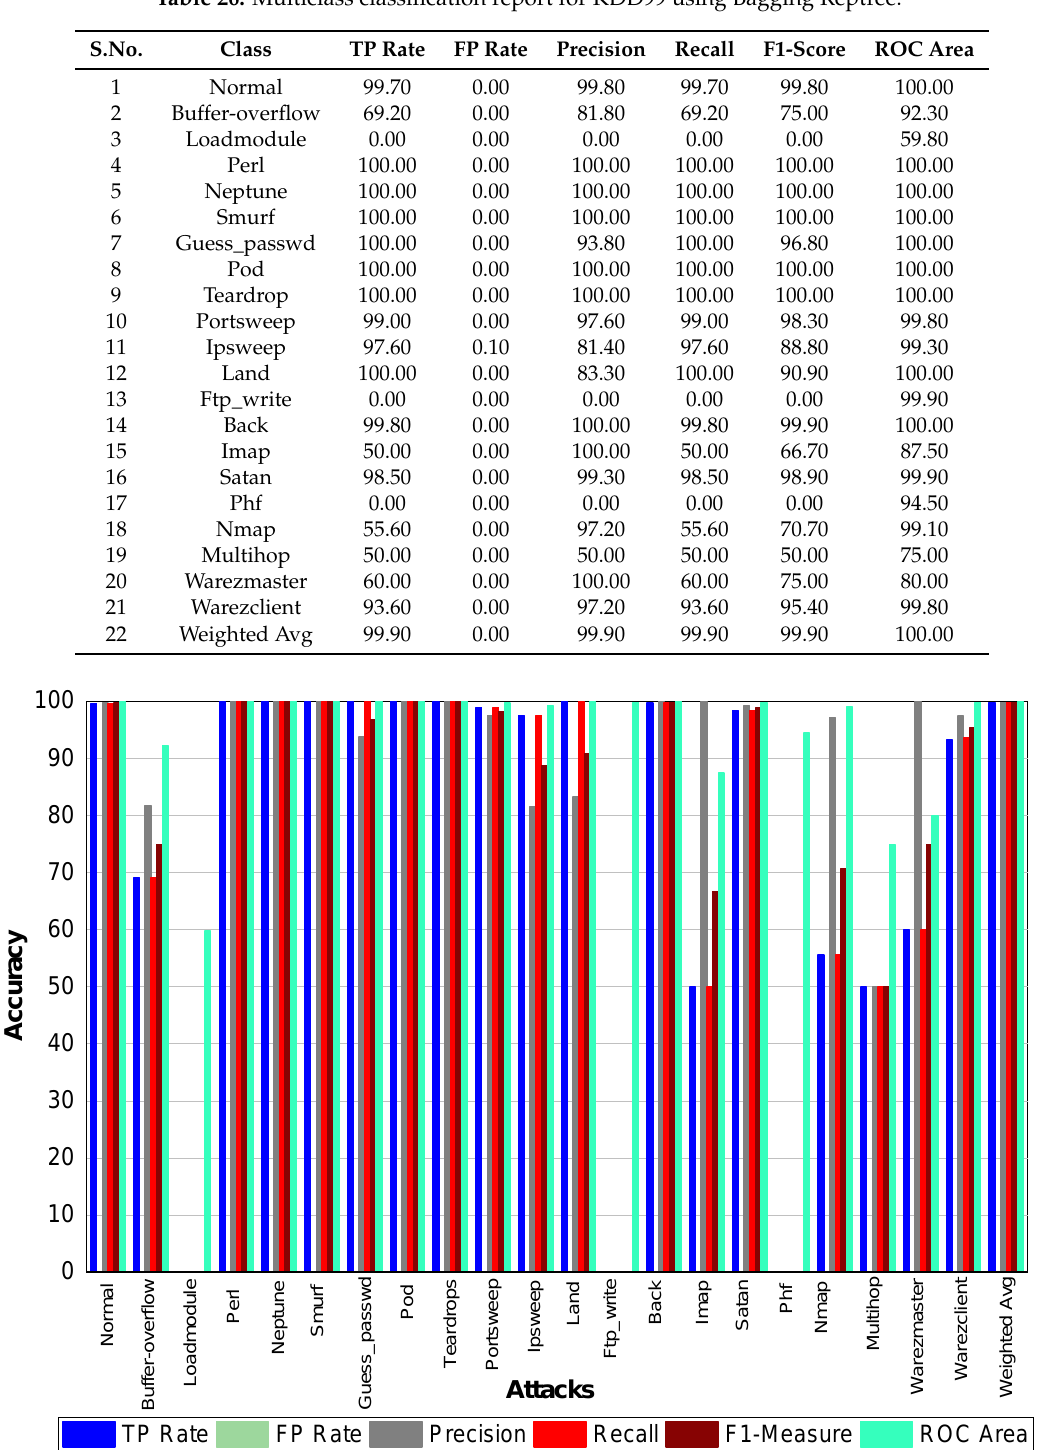
Figure 8. Classification report for the Bagging Reptree kdd99